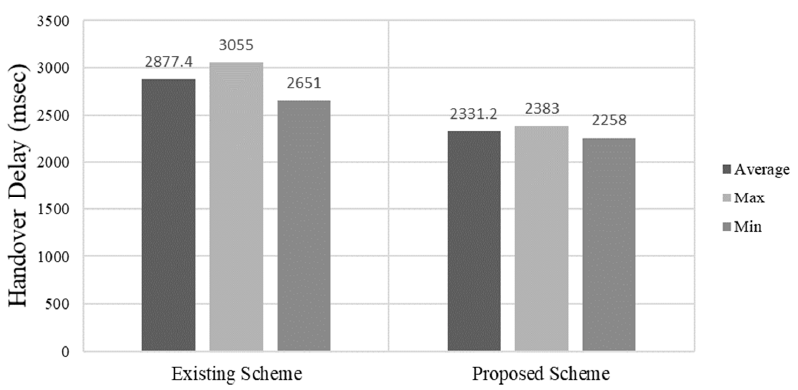
Figure 29. The AA handover delay.